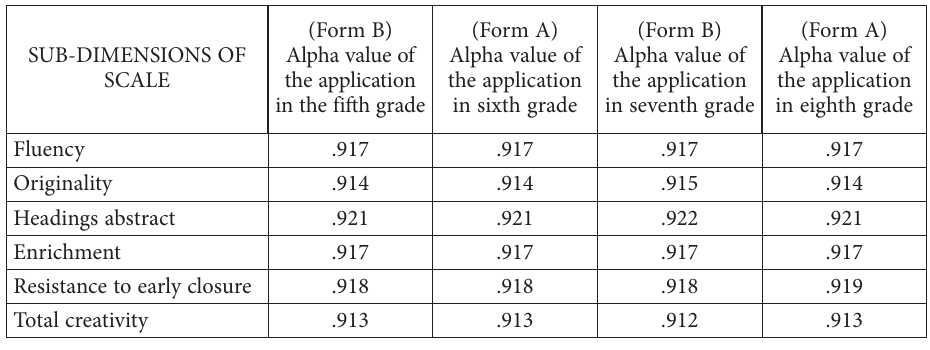
Table 2. Torrance Tests of Creating Thinking Scale Figure Form A and Form B reliability test results (source: created by author)